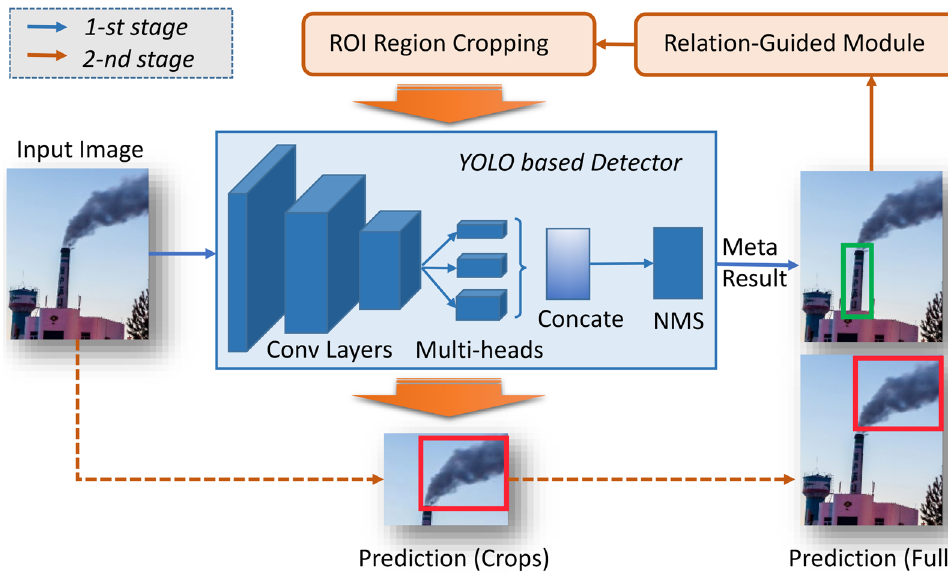
Figure 3. The framework of TSSD algorithm. In the first stage, a YOLO based detector locates chimney in the image, which may produce the meta result as none, one or more prediction boxes; in the second stage, the relation-guided module is to analyze the previous result and carry out ROI region cropping. Then the detector predicts the location of the smoke in the crops, maps this location back to the original image, and eventually outputs the prediction bounding box of factory smoke on the full image.